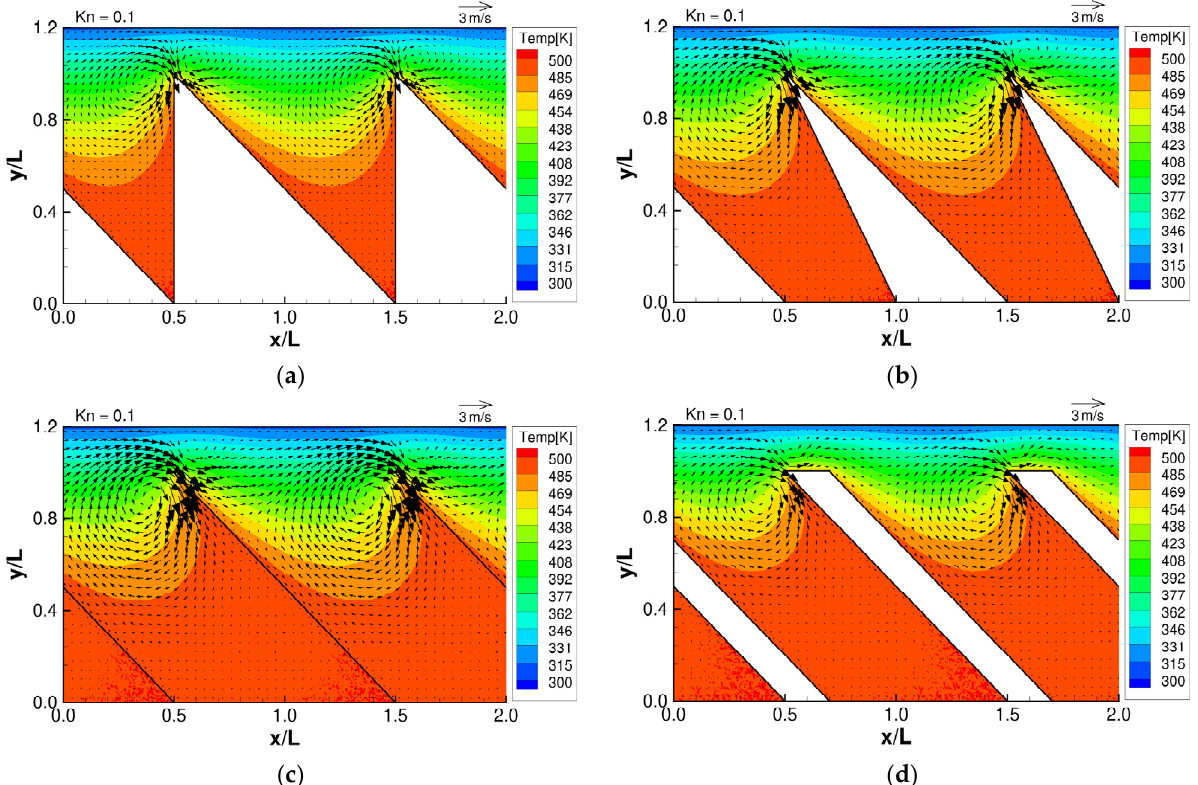
Figure 3. Flow distributions and temperature distributions for ( a ) ratchet, ( b ) modified ratchet, ( c ) oblique plate, and ( d ) oblique ridge, at Kn = 0.1 .